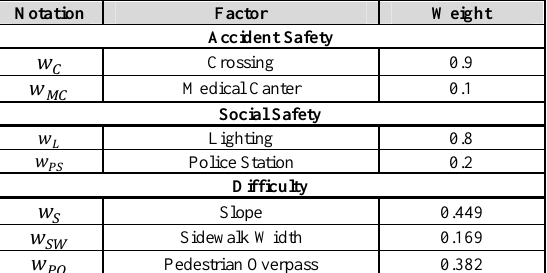
Table 2. Extracted weights of the factors by AHP